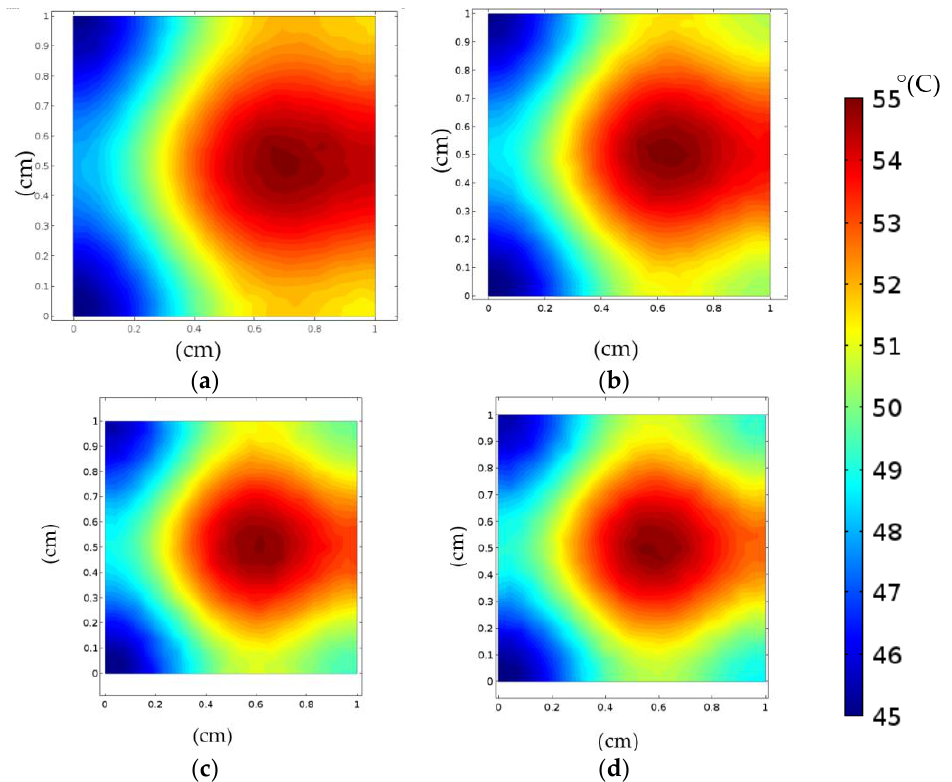
Figure 10. The heat source surface temperature contours MLM heat sink of 30 mL/min HTF flow rate and 15 W power rate for ( a ) one-layer; ( b ) two-layers; ( c ) three-layers; ( d ) 4-layers.